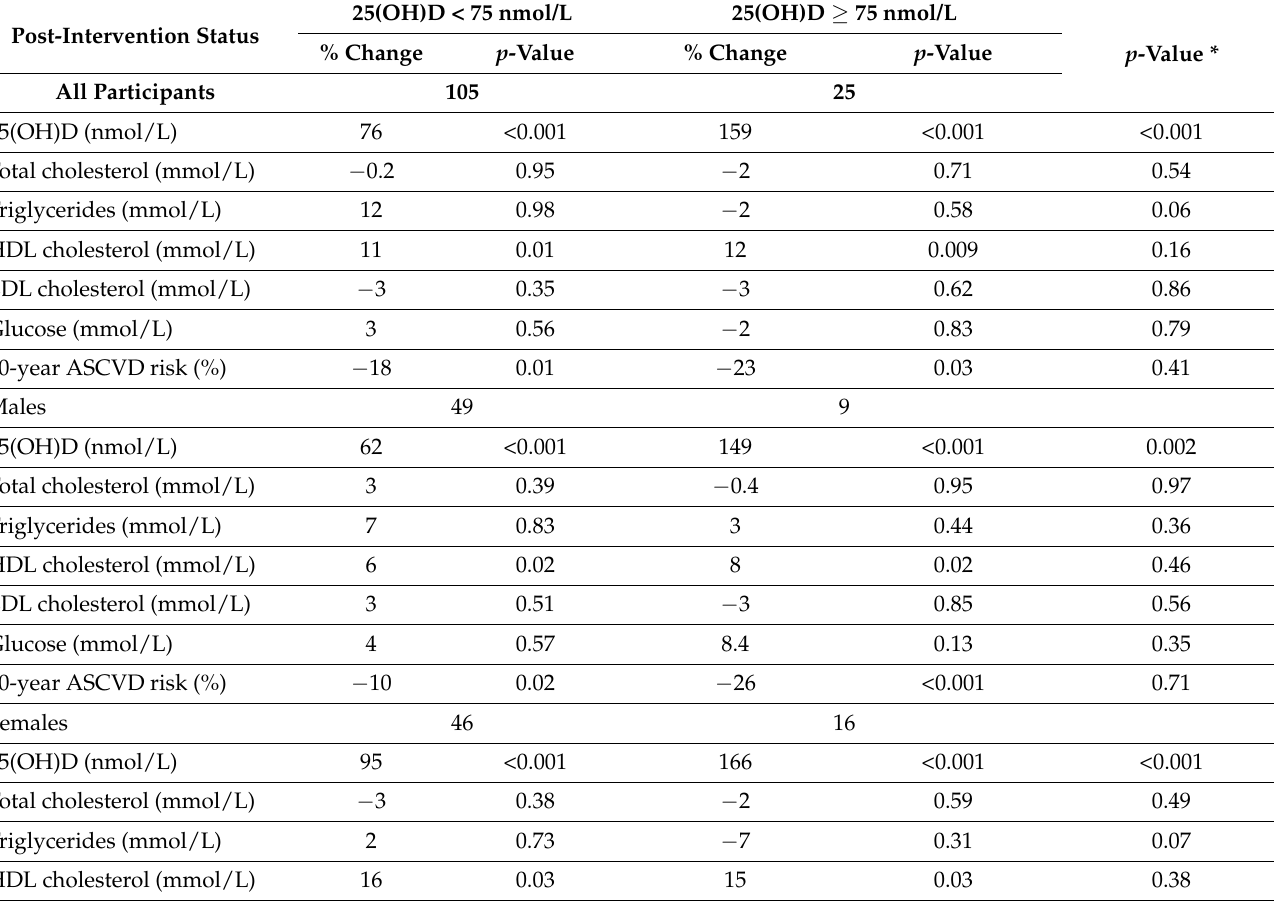
Table 3. Percentage changes in ASCVD risk and components according to post-supplementation 25(OH)D